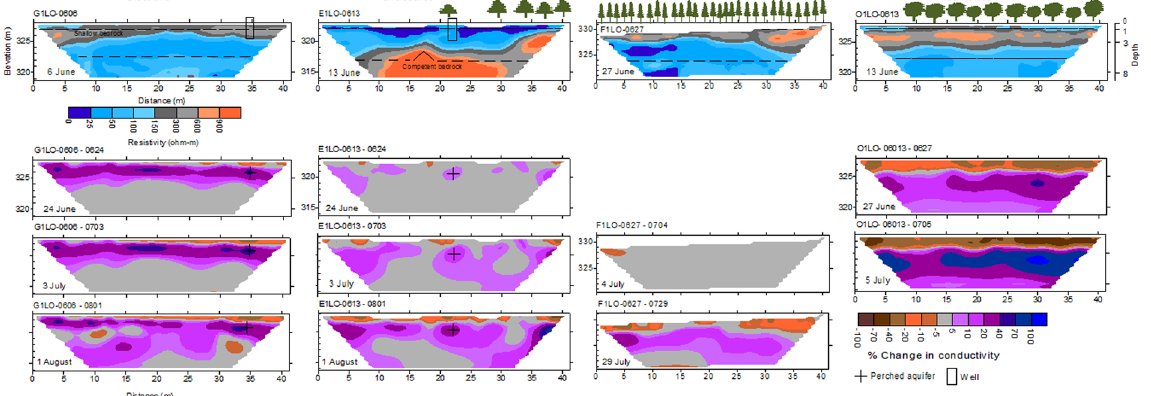
Figure 4. Electrical resistivity images for a grassland, a grassland encroached by a juniper species (eastern redcedar, Juniperus virginiana ), a juniper woodland and an oak forest. Top images are background images of resistivity and subsequent images are transient images shown as % change in conductivity. A positive change in conductivity corresponds to higher conductivity and higher moisture. Images were developed from latitudinal transects deployed with 56 electrodes between June and August 2014.